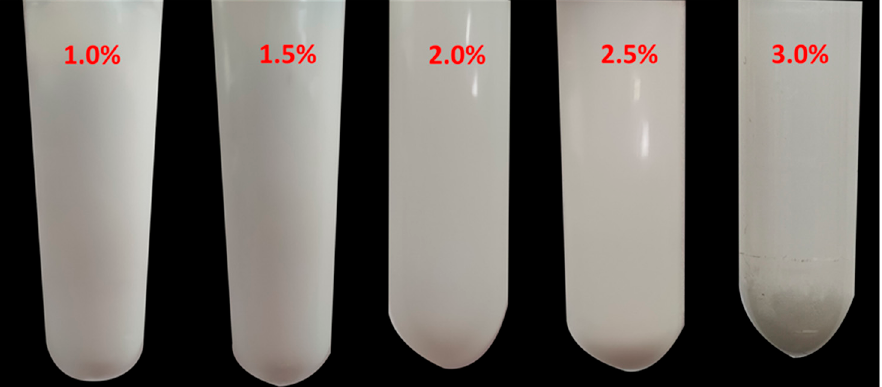
Figure 13. Effect of A-TiO 2 content on dispersion stability of PU-TiO 2